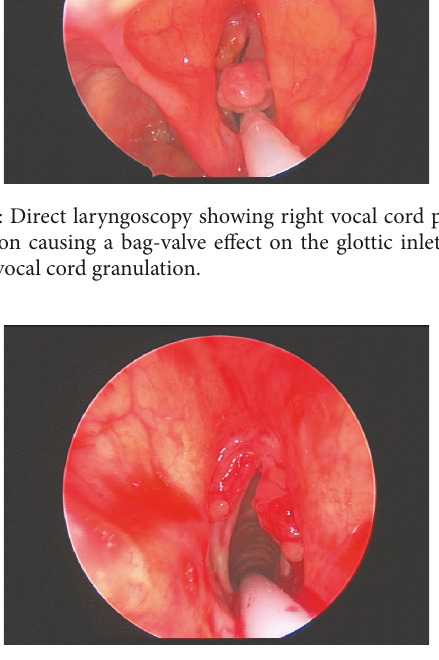
Figure 2: Direct laryngoscopy immediately following debridement of laryngeal lesions on both vocal cords to reestablish airway and to send tissue for histological and microbiological investigations.